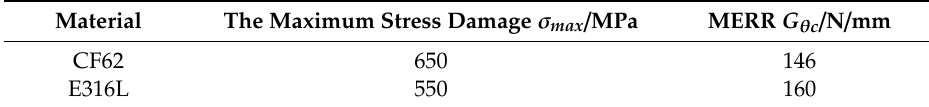
Table 6. Mechanical properties of the crack